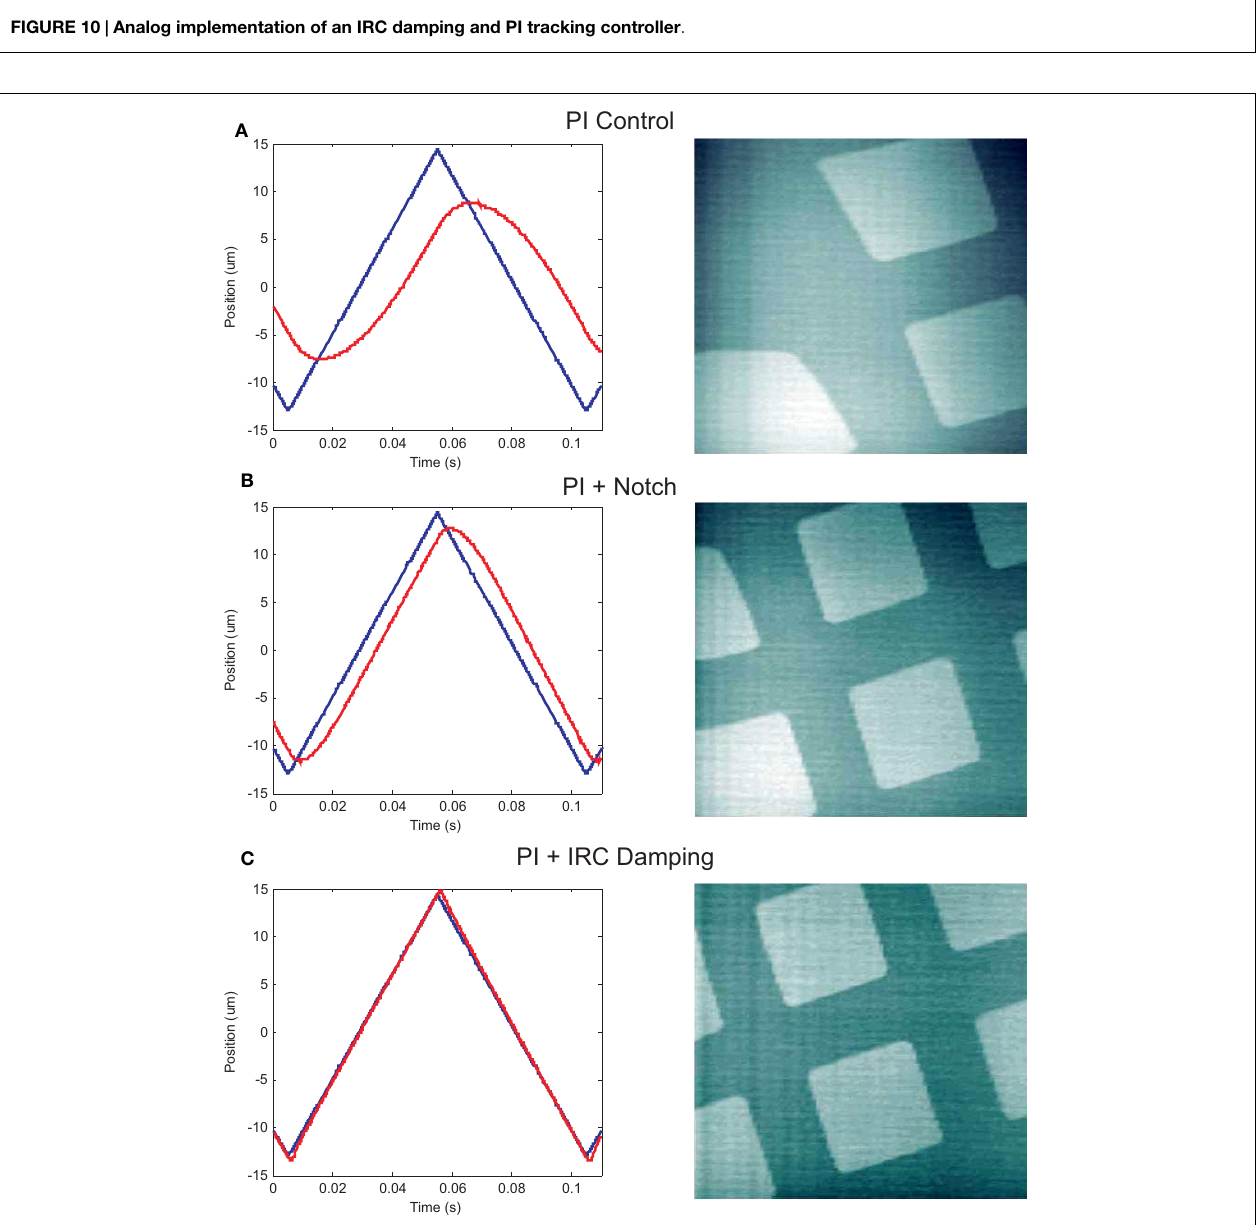
FIGURE 11 | The x -axis scanning performance and resulting image for each of the three controller strategies . The scanning trajectory is a full-range (27 (cid:22) m) 10Hz triangle wave. The response and imaging performance of the PI controller is plotted in (A) . The improved performance of the inversion and damping controllers can be observed in (B) and (C)